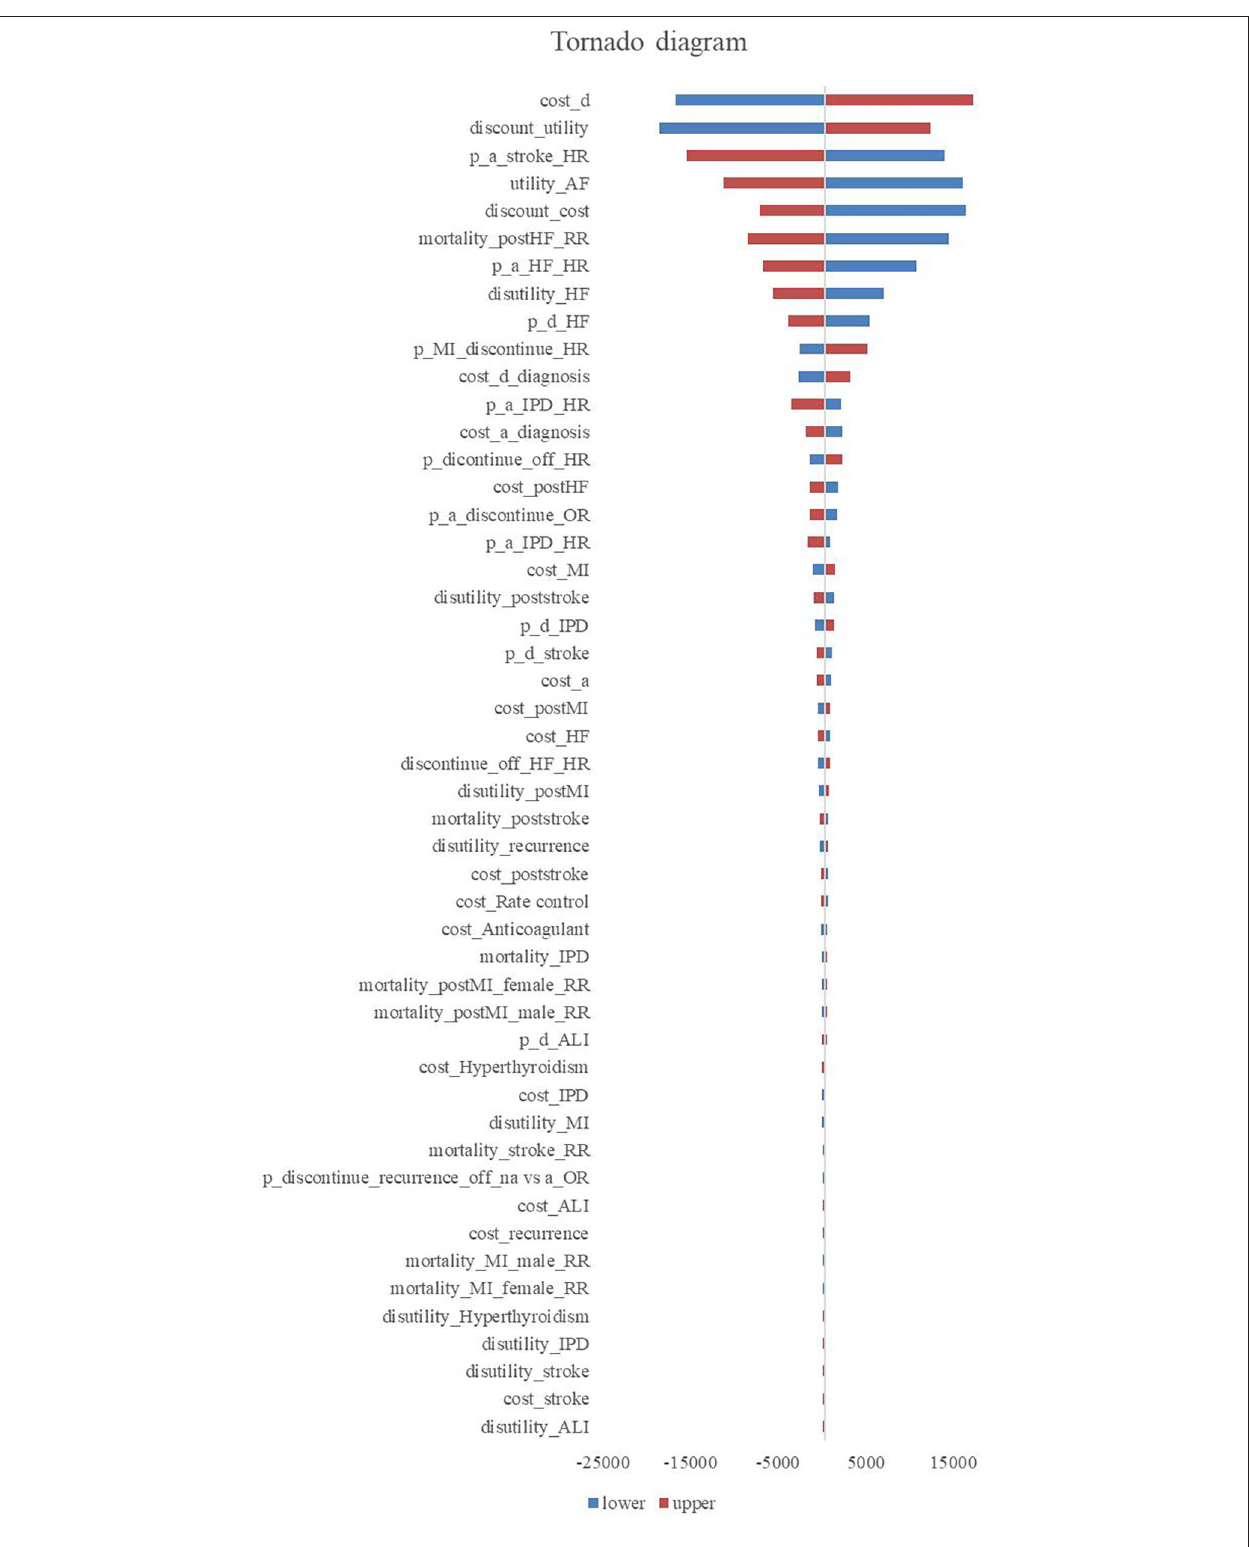
FIGURE 3 | Tornado